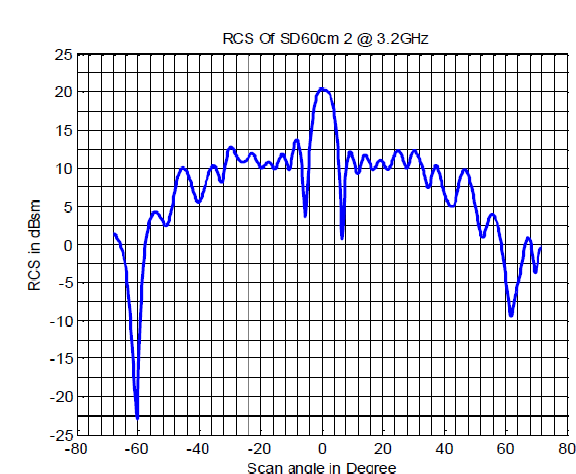
Figure 6(b): Plot of measured RCS values of SD_60cm_1 in VV polarization at S-band (3.2GHz)